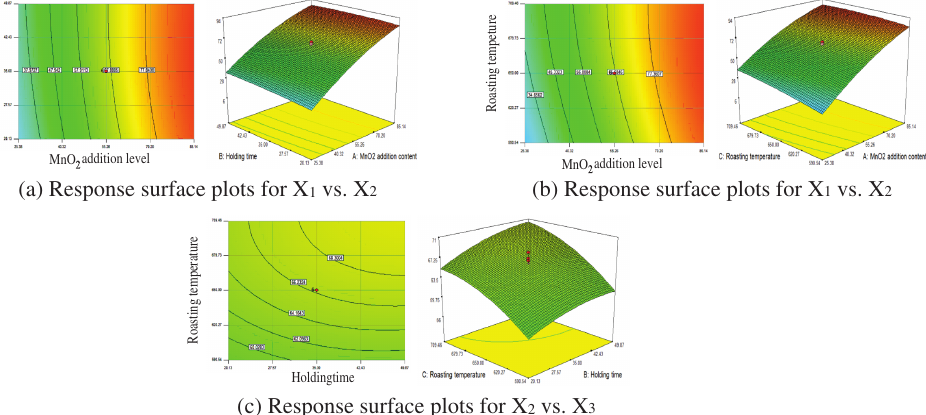
Figure 2: Response surface plots for MnO 2 adding level vs. holding time vs. roasting temperature. (a) Response surface plots for X 1 vs. X 2 . (b) Response surface plots for X 1 vs. X 3 . (c) Response surface plots for X 2 vs. X